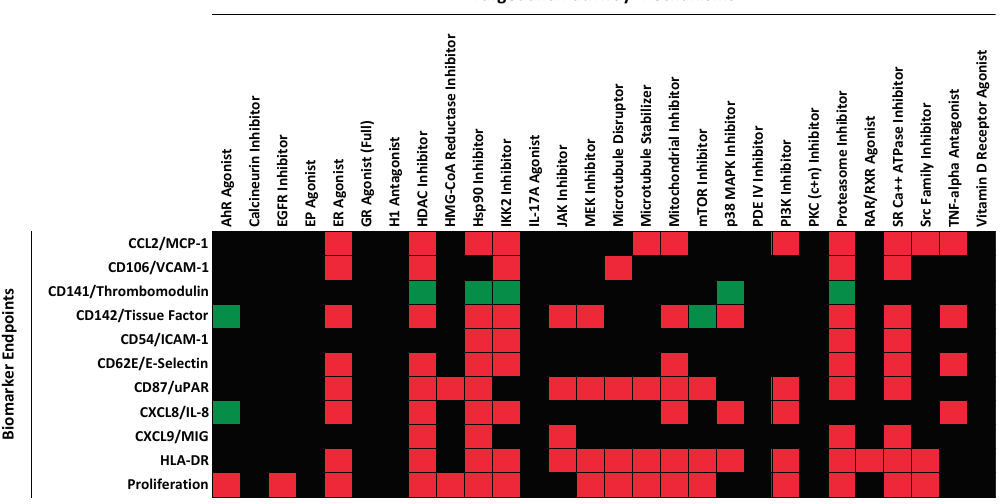
Figure 1. Heat map showing the effect of mechanisms on the cell surface protein expression levels of biomarker endpoints in the BioMAP 3C system. Mechanisms causing an increase in the level of the indicated biomarker are shown in green, and mechanisms resulting in decreased levels are shown as red. Black indicates that the levels were unchanged (no missing data). Data were generated from multiple compounds and an average profile representing the mechanism class was generated. The data used to generate this figure are taken from reference [21] and are included for convenience in Supplemental Table